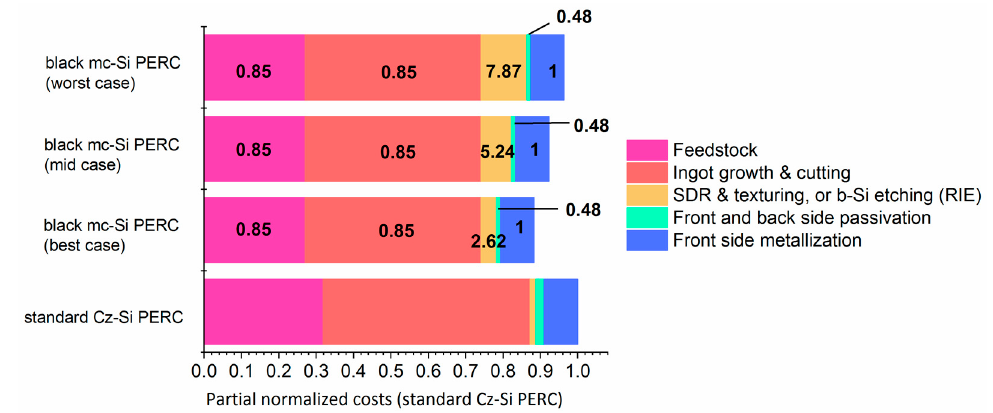
Figure 4. Sum of the normalized costs for the PERC process steps that are different between the reference (standard texturized Cz-Si PERC) and the black mc-Si PERC. Step costs are normalized over the total steps costs for the reference device. The numbers on the black mc-Si PERC show the multiplying factor for each step in the process compared to the reference for the given process step.